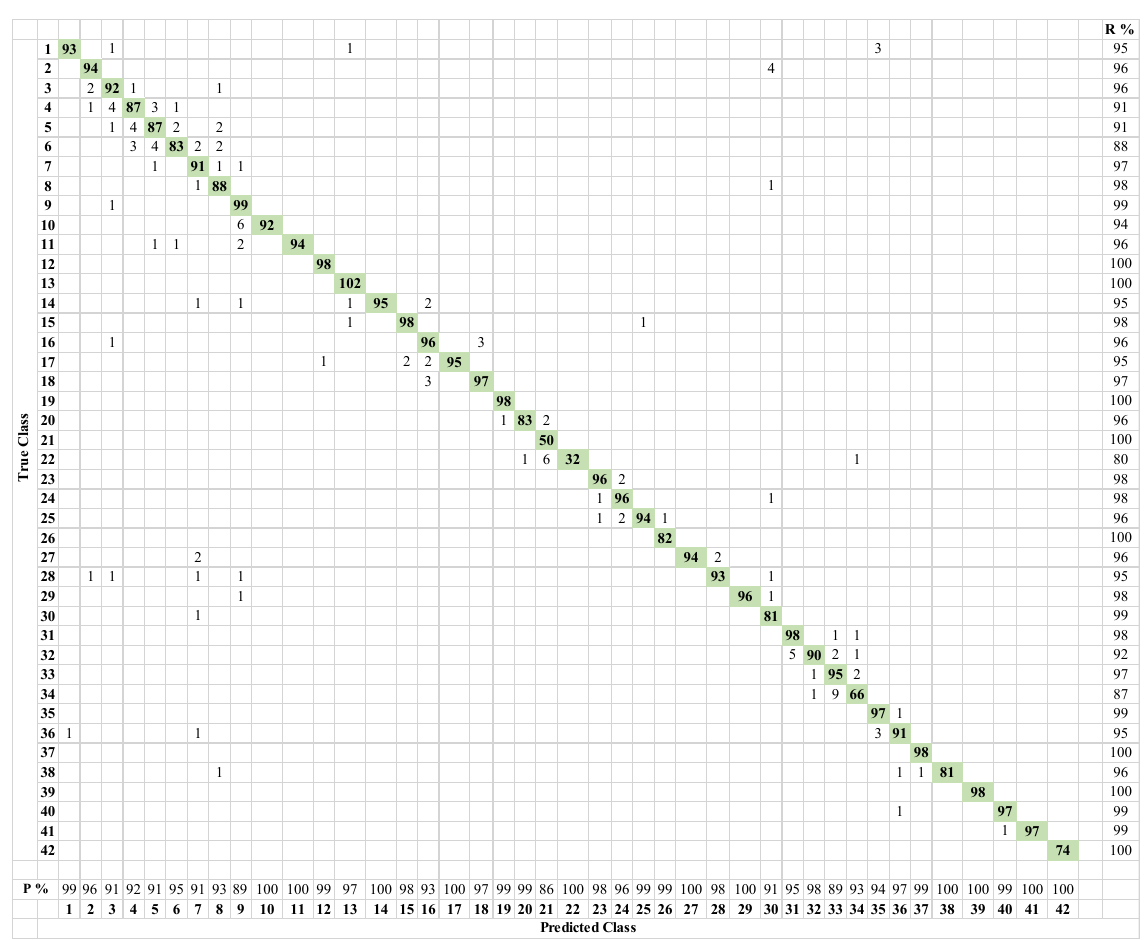
Figure 16. Test confusion matrix of ResNet18 on 10% independent test data from the data augmented through eight virtual sensors, 96.36% accuracy. (1: normal; 2–8: unbalance with (6, 10, 15, 20, 25, 30, 35) g mass; 9–12: horizontal misalignment of (0.5, 1, 1.5, 2) mm; 13–18: vertical misalignment of (0.51, 0.63, 1.27, 1.4, 1.78, 1.9) mm; 19–22: overhung position ball fault with (0, 6, 20, 35) g unbalance; 23–26: overhung position cage fault with (0, 6, 20, 35) g unbalance; 27–30: overhung position outer race fault with (0, 6, 20, 35) g un-balance; 31–34: underhung position ball fault with (0, 6, 20, 35) g unbalance; 35–38: underhung position cage fault with (0, 6, 20, 35) g unbalance; 39–42: underhung position outer race fault with (0, 6, 20, 35) g unbalance) (R: Recall, P: Precision).